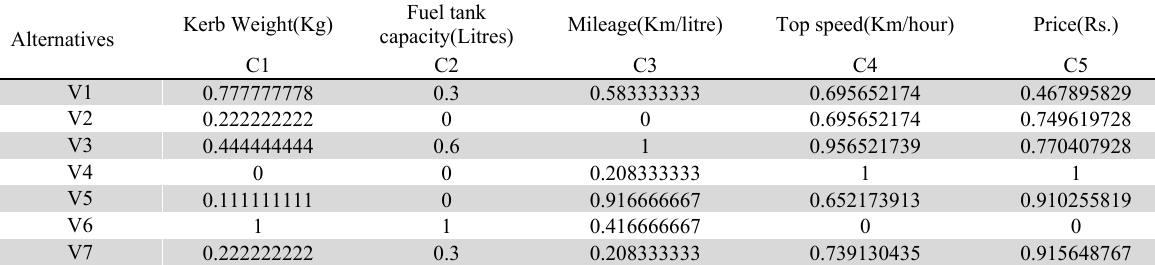
Normalized matrix